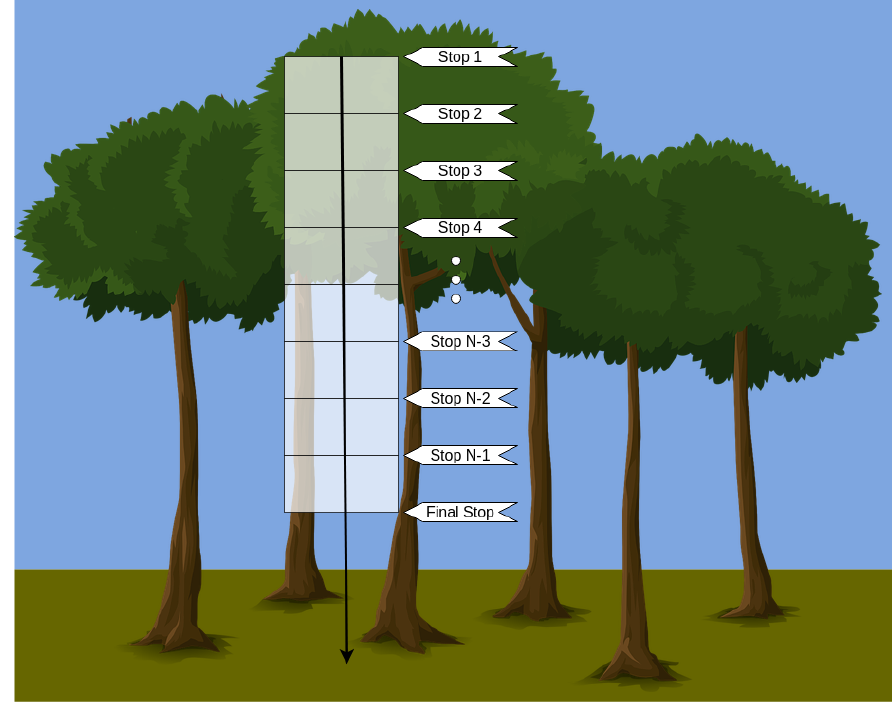
Figure 1. Illustration of the cylinder-transect